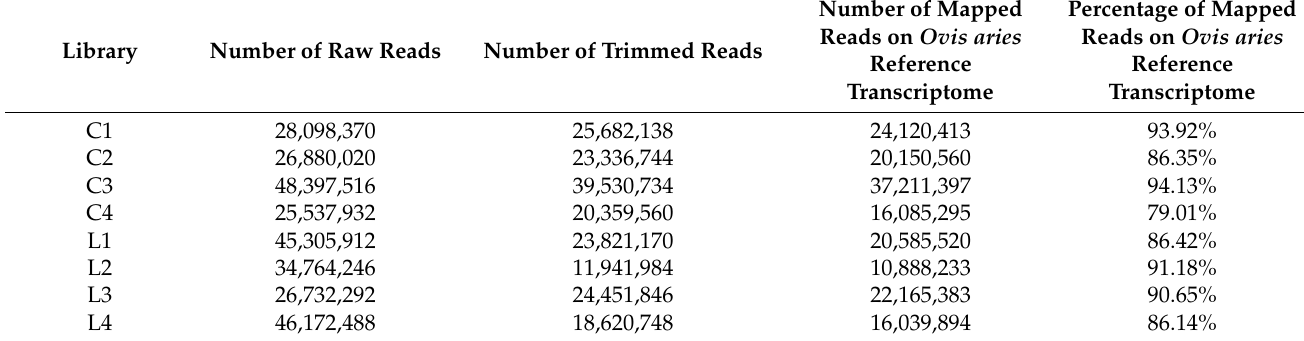
Table 2. Summary statistics for the Illumina sequencing and aligning against Ovis aries reference